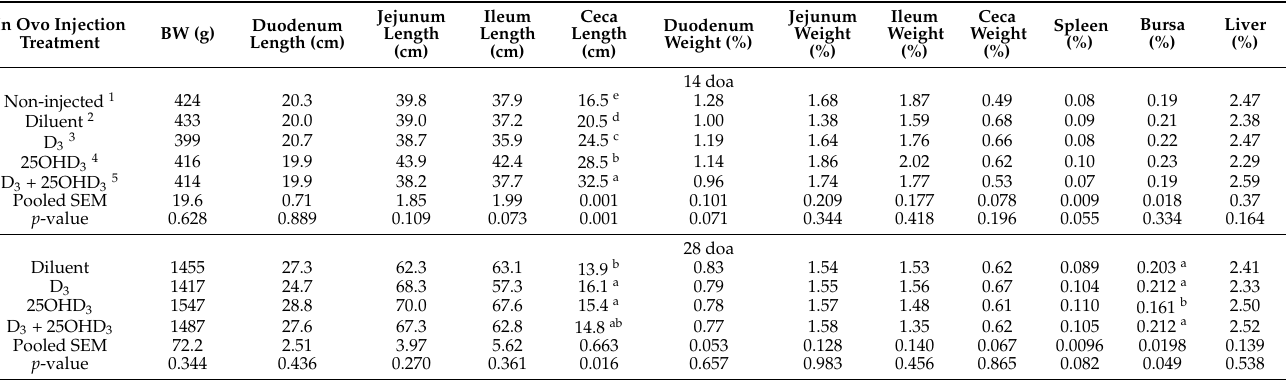
Table 1. Effects of in ovo injection treatment (non-injected, diluent-injected (50 µ L) and 50 µ L of diluent containing 2.4 µ g of vitamin D 3 (D 3 ), 2.4 µ g of 25-hydroxycholecalciferol (25OHD 3 ), or 2.4 µ g